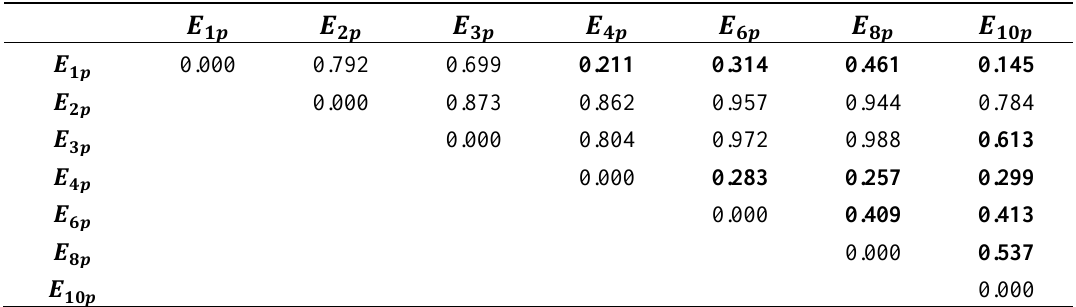
Table 7. SA values of endmember set after the second processing step. The values shown in bold italics are those less than the threshold